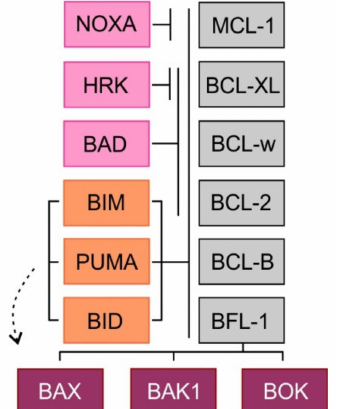
Figure 2. Binding profile of pro-apoptotic BH3 domain-only proteins and multi-domain e ff ector proteins to pro-survival proteins. BH3 domain-only proteins are depicted in orange (direct activators) and pink